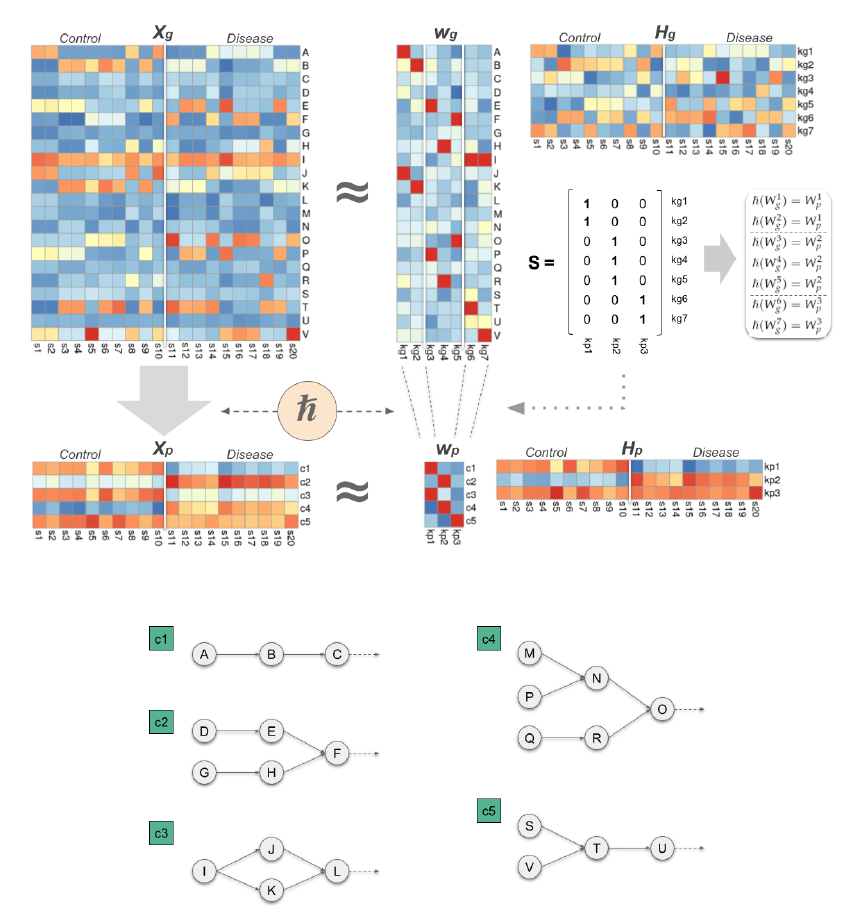
Figure 1. Description of the obtained hierarchical model applied to a controlled simulation, repre- senting a cohort of 20 individuals divided into 2 different phenotypic groups (Control and Disease). The use of the Hipathia function on X g provides the pathway activity matrix ( X p = (cid:125) ( X g ) composed of 5 rows, corresponding to the 5 signalling cascades ( [c1, c2, c3, c4, c5] ) modelled by Hipathia (below). These 5 cascades involve 22 genes (from A to V) responsible for regulating the biological process under study. The S matrix shows the hierarchical relationship between the 3 components obtained at the pathway level ( W p ) and the 7 components obtained at the gene level ( W g ). As can be seen, the first component at the pathway level ( kp1 ) regulates the biological process by overactivating the c1 and c3 signalling cascades. In this case, the hierarchical model obtains two different strategies (components) at the gene level to produce this effect: while kg1 overactivates the genes A and J, kg2 overactivates the genes B and K. Likewise, the mixing matrix obtained at the pathway level ( H p ) shows two different configurations for the two groups of individuals. In this case, while the Control group weights the first component ( kp1 ), the Disease group focuses on the second component ( kp2 ), with kp3 being shared by both